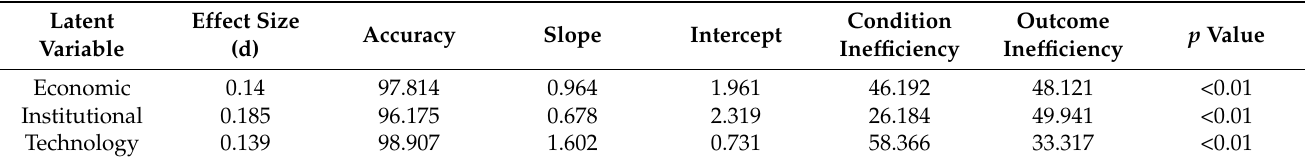
Table 9. Results of the necessity analysis.